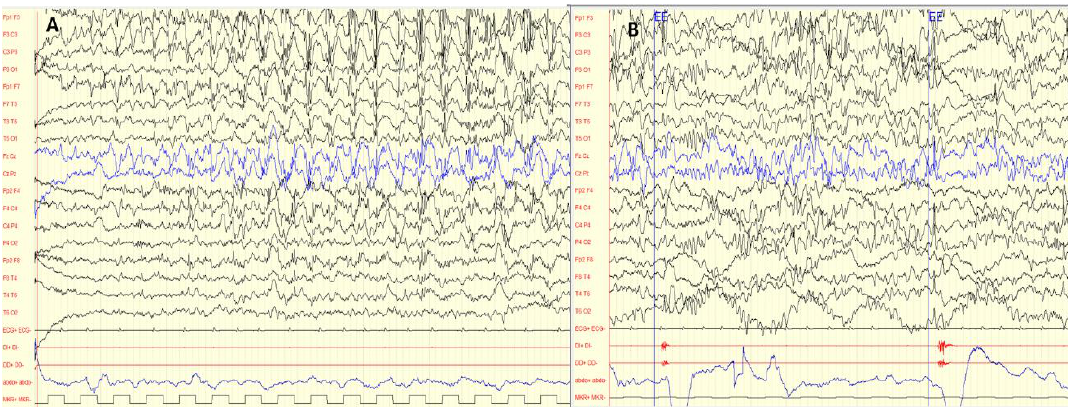
Figure 1. Electroencephalogram (EEG) of the patient at six years of age. ( A ) Interictal EEG. Bilateral polyspike-and-wave discharges with frontal predominance. ( B ) Multifocal epileptiform abnormalities .